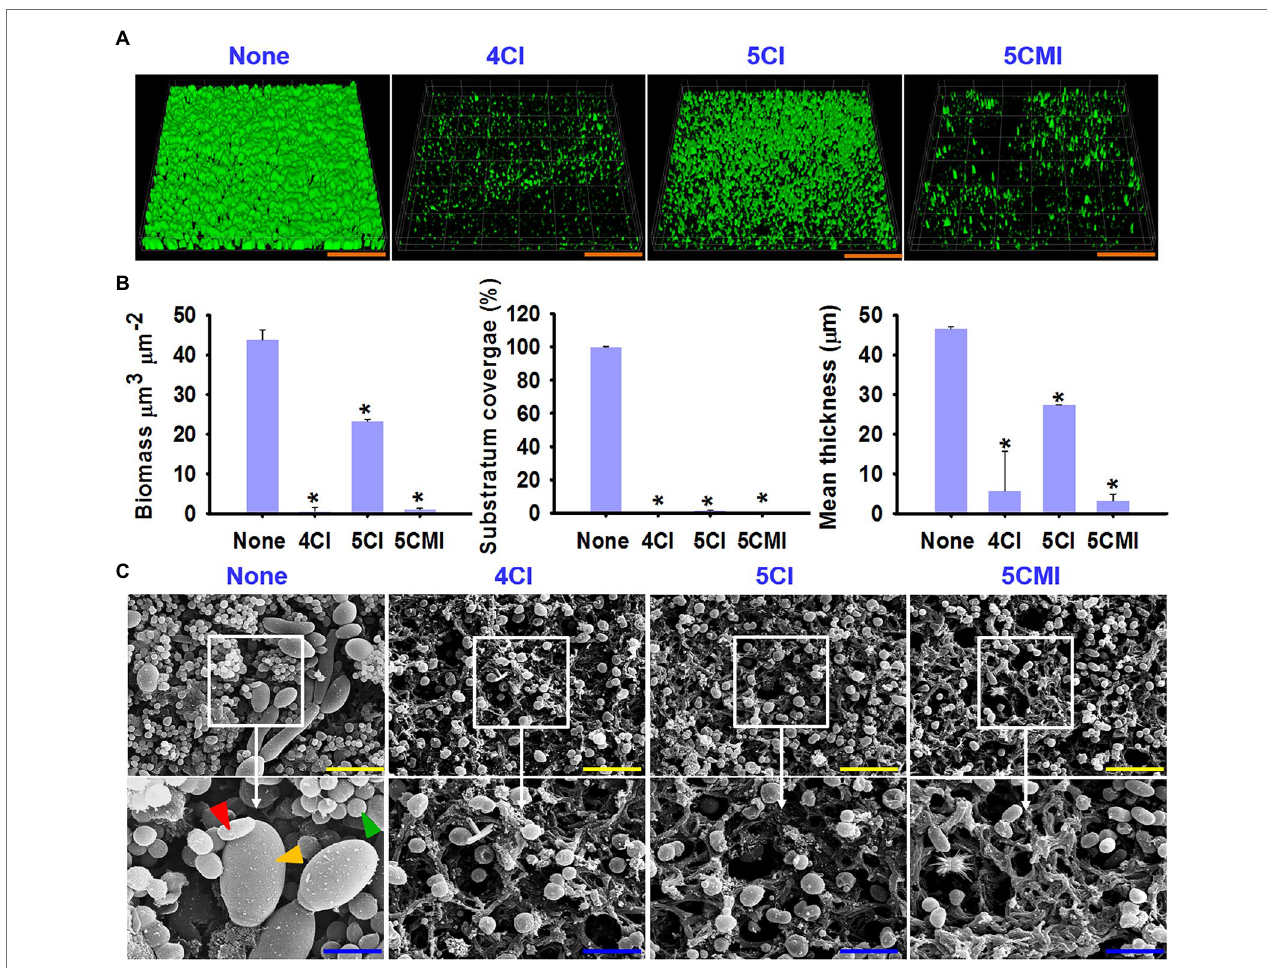
FIGURE 9 | (A) Confocal laser scanning microscopy (CLSM) images of polymicrobial biofilms ( S. aureus ATCC 6538, C. albicans DAY 185, and UPEC) grown in the presence of the three indole derivatives at 100 μ g/ml, (B) COMSTAT analysis of polymicrobial biofilms ( S. aureus ATCC 6538, C. albicans DAY 185, and UPEC), (C) SEM images of polymicrobial biofilms ( S. aureus , UPEC, and C. albicans ) grown in the presence of the three indole derivatives at 100 μ g/ml. Red, yellow, and green arrows represent UPEC, C. albicans , and S. aureus , respectively. * p < 0.05 vs. non-treated controls. Orange, yellow, and blue scale bars represent 100, 10, and 3 μ m,